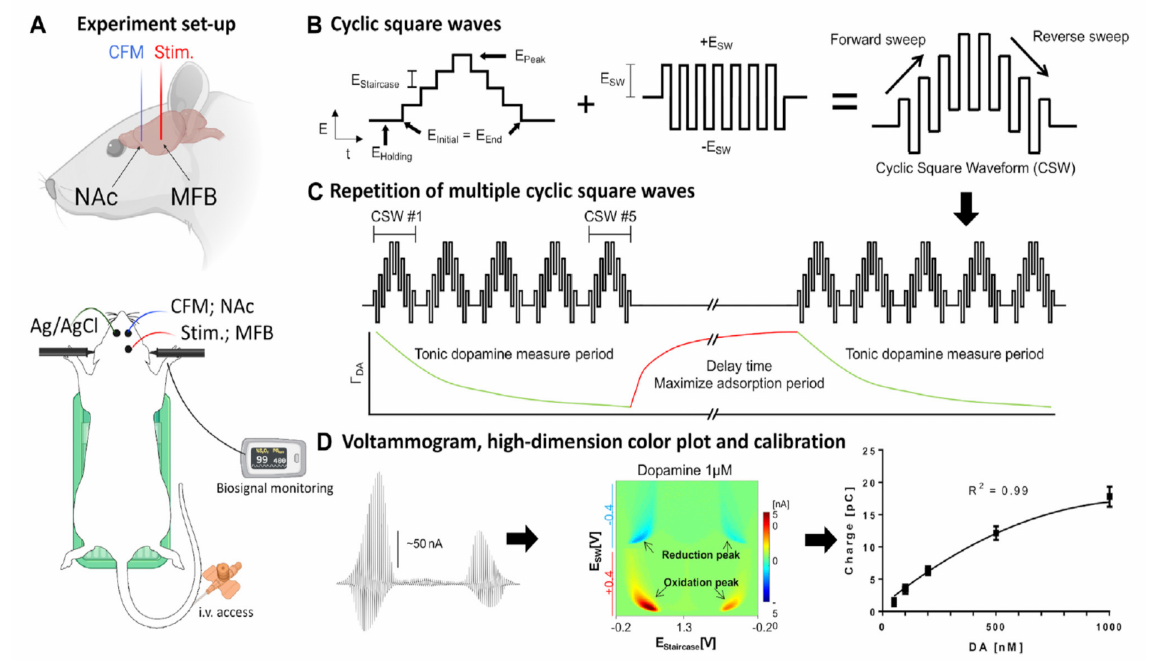
Figure 9. Setup of clinical voltammetry research. ( A ) Rat surgery setup. Recording and stimulating electrodes were inserted unilaterally into the core of the nucleus acumens and medial forebrain bundle, respectively. The counter-reference Ag/AgCl electrode was inserted contralaterally into cortical tissue. The rat was placed in a stereotactic frame with tail vein access, heating pad, and a pulse oximetry monitoring electrode. Elements of the Figure were created using Biorender.com. ( B , C ) Schematic design of waveform-CSWV applied to the CFM and its response. ( D ) Left-to-right: raw voltammogram following the removal of background currents, high-dimensional pseudo-color plot, M-CSWV signal calibration with tonic dopamine experiment ( n = 4 electrodes). Reprinted by permission from